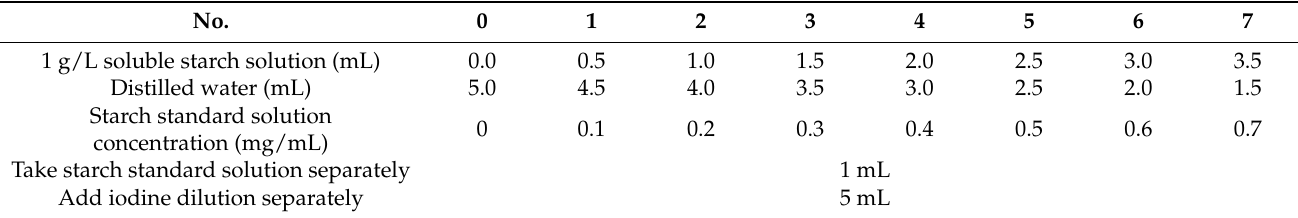
Table 1. Preparation of standard solutions of starch